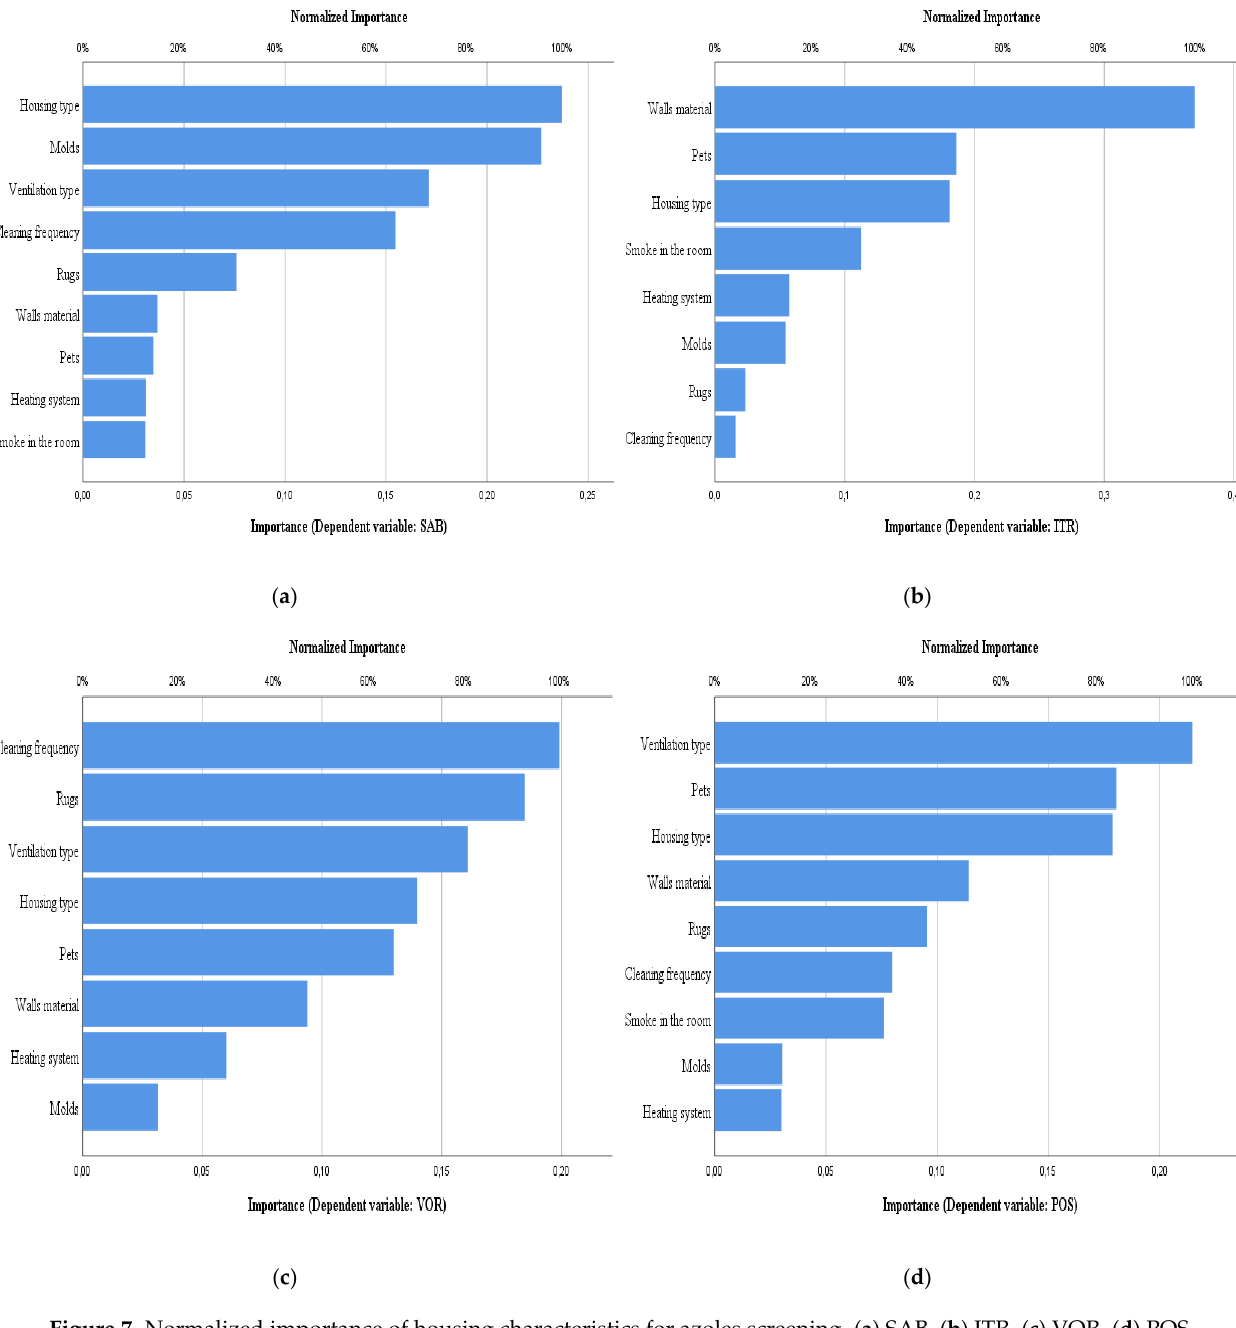
Figure 7. Normalized importance of housing characteristics for azoles screening. ( a ) SAB, ( b ) ITR, ( c ) VOR, ( d ) POS.